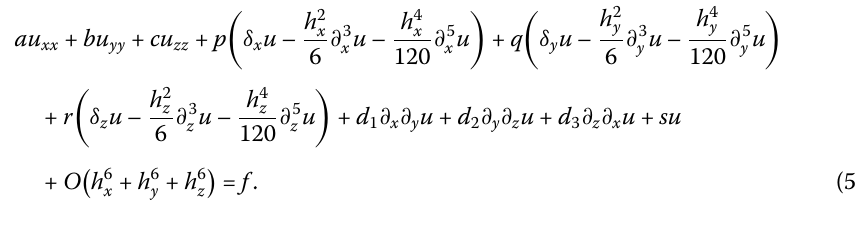
here δ x , δ y and δ z are central difference operators for u x , u y , u z . Substituting Eqs. (2)–(4) into Eq. (1), we